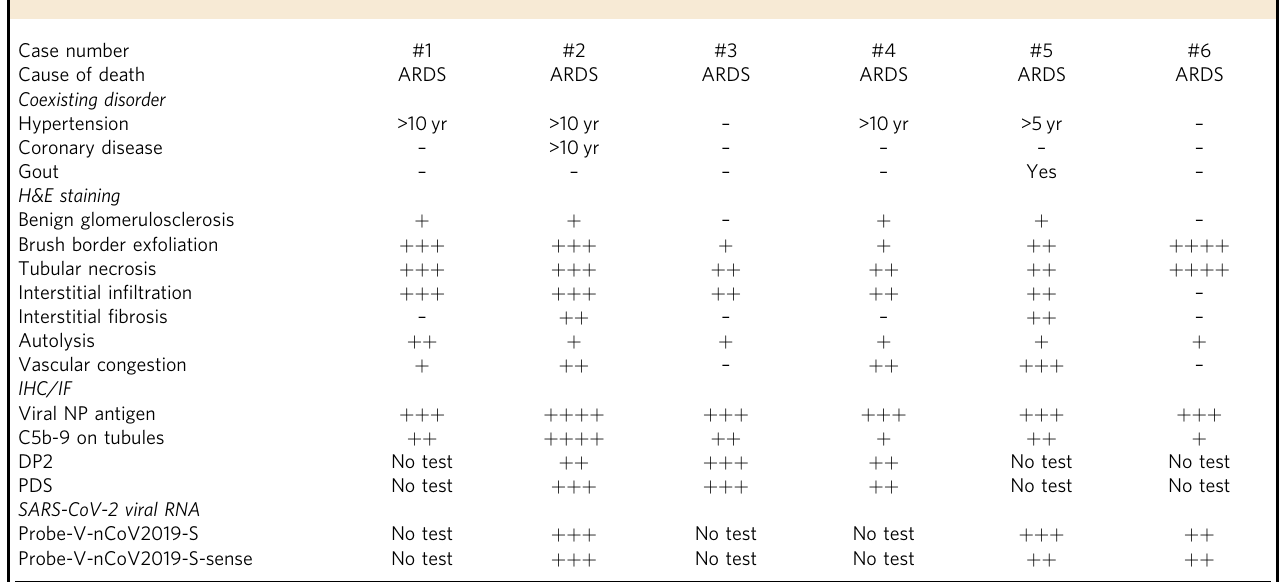
Table 2 The pathologic fi ndings of kidney tissues from COVID-19